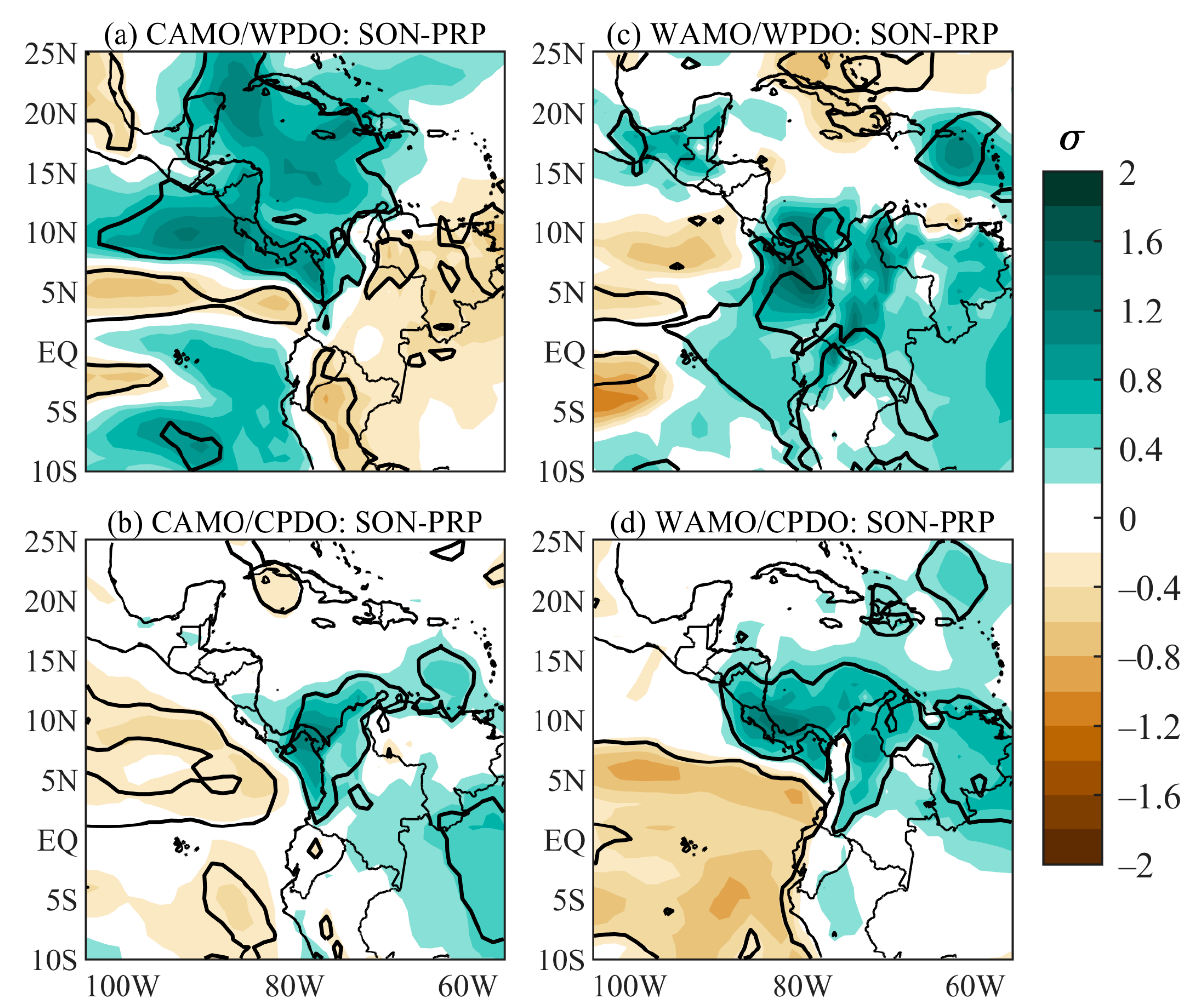
Figure 6. September–November precipitation standardized anomalies over Central America and northwestern South America during intense CJ events of the: ( a ) CAMO/WPDO; ( b ) CAMO/CPDO; ( c ) WAMO/WPDO; and ( d ) WAMO/CPDO mean states. Shades interval is every 0.2 SDs. The continuous line encompasses significant precipitation anomalies at a 95% confidence level based on the Student’s t -test.